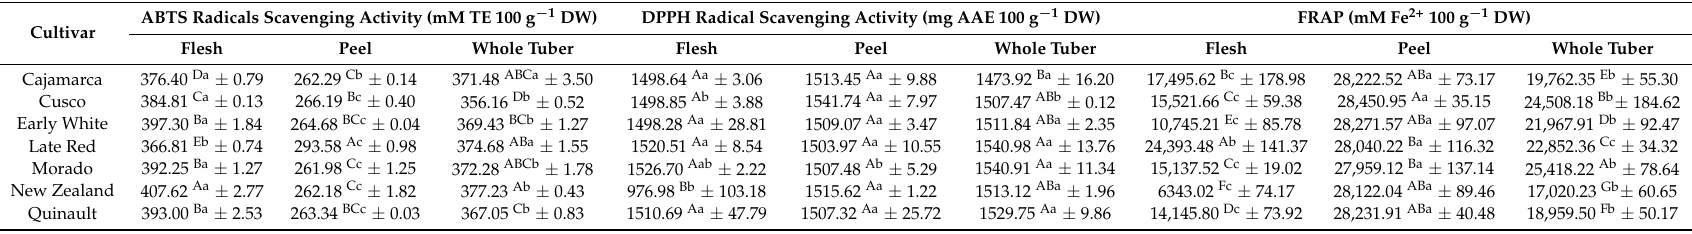
Table 5. ABTS radical scavenging activity (mM TE 100 g − 1 DW), DPPH radical scavenging activity (mg AAE 100 g − 1 DW), and FRAP (mM Fe 2+ 100 g − 1 DW) of the flesh, peel, and whole tuber of different yacon